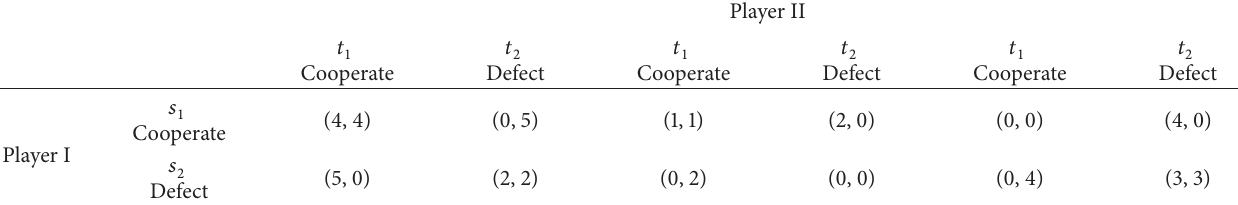
Table 1: Prisoner’s Dilemma game matrices.